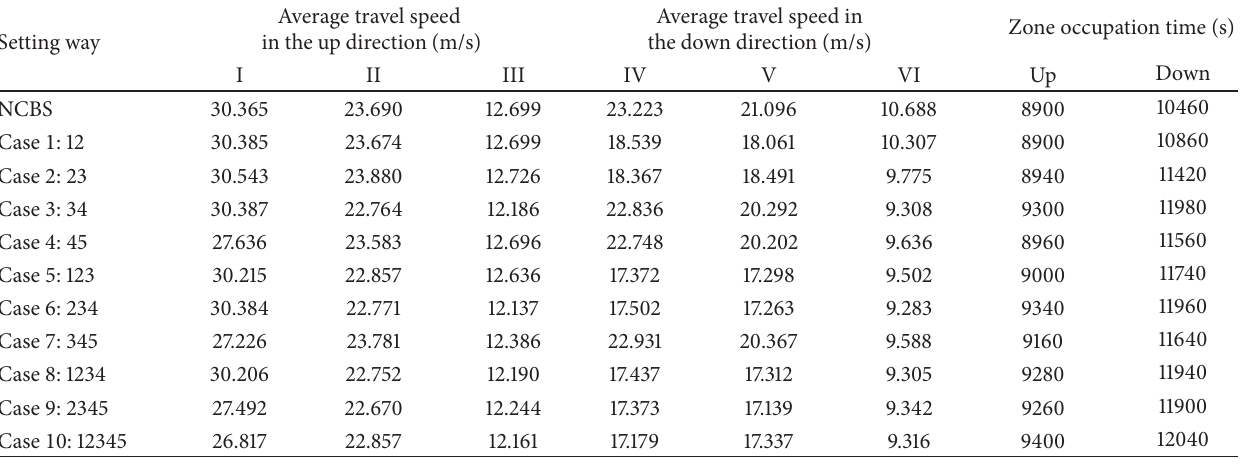
Table 5: Results of NCBSs setting with different continuous way.